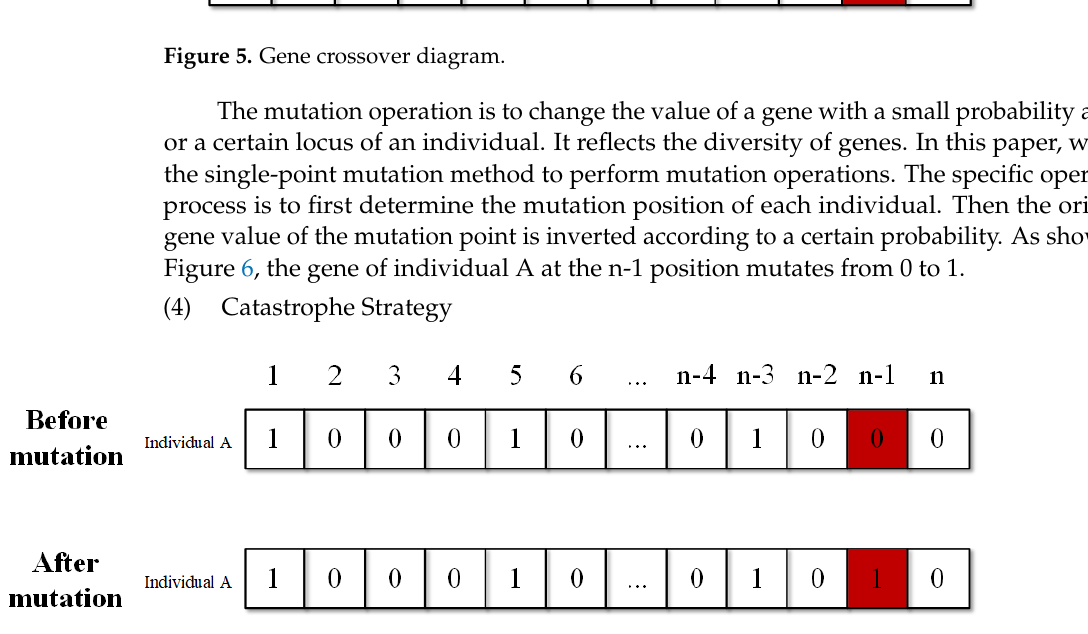
Figure 6. Gene mutation diagram.